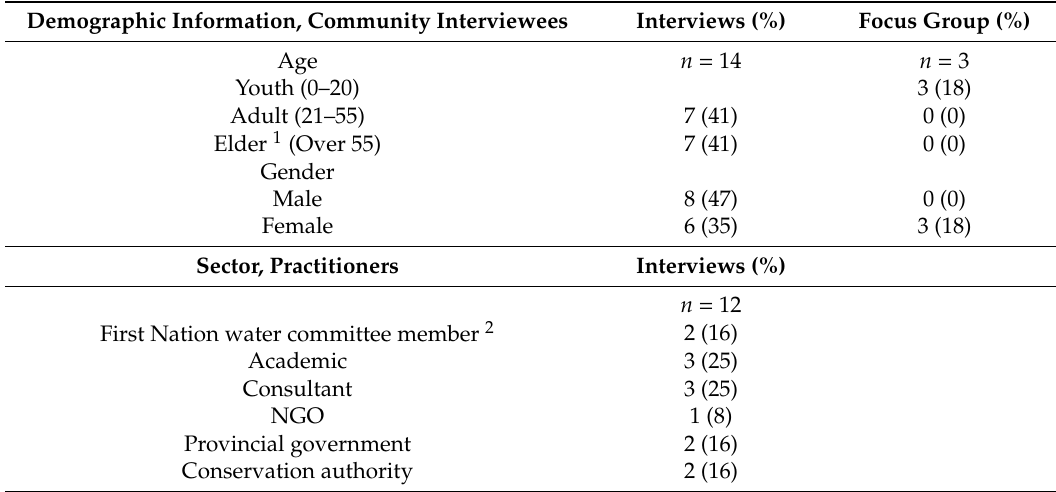
Table 1. Demographic and sector information for